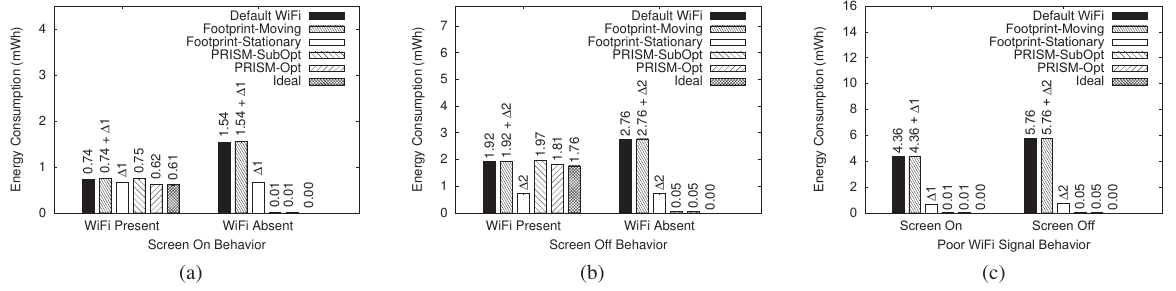
Figure 10: Wi-Fi energy consumed every minute for (a) screen ON, (b) screen OFF, and (c) under poor Wi-Fi signals. For Footprint, Δ1 is estimated to be 0 . 673 mWh for screen on and Δ2 is estimated to be 0 . 719 mWh for screen off conditions. print scans for Wi-Fi first and later records all places which do not have Wi-Fi bloating its history list. Even in areas with Wi- Fi, unless the user moves, it does not scan even if the Wi-Fi ra- dio is turned off after screen off delay. PRiSM, however, checks for Wi-Fi availability every sampling period and connects to Wi-Fi if needed, else, it maintains the radio in off state. Also, it con- nects directly to the AP without scanning and avoids turning on Wi-Fi in poor signal strength areas and hence saves energy intel- ligently. Since energy measurements for Footprint is not available and implementing the entire system is out of scope in our experi- ments, we combine the accelerometer energy value ( 0 . 667 mWh )